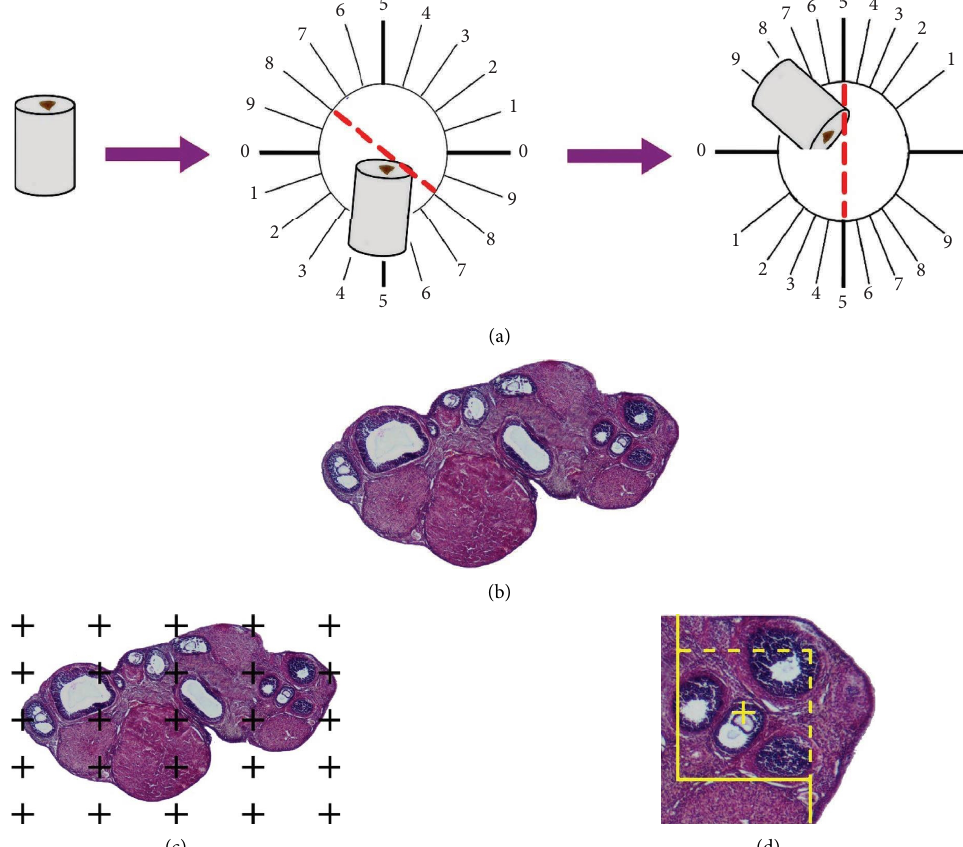
Figure 1: Ovarian cylindrical parafn block was divided into sections using isotropic uniform random (IUR). (a) Sections of ovarian tissue were stained with hematoxylin and eosin (H&E). (b) Te volumes of the cortex, medulla, and corpus luteum were measured using a point- counting technique. (c) Te optical dissector method was used to estimate the number of follicles